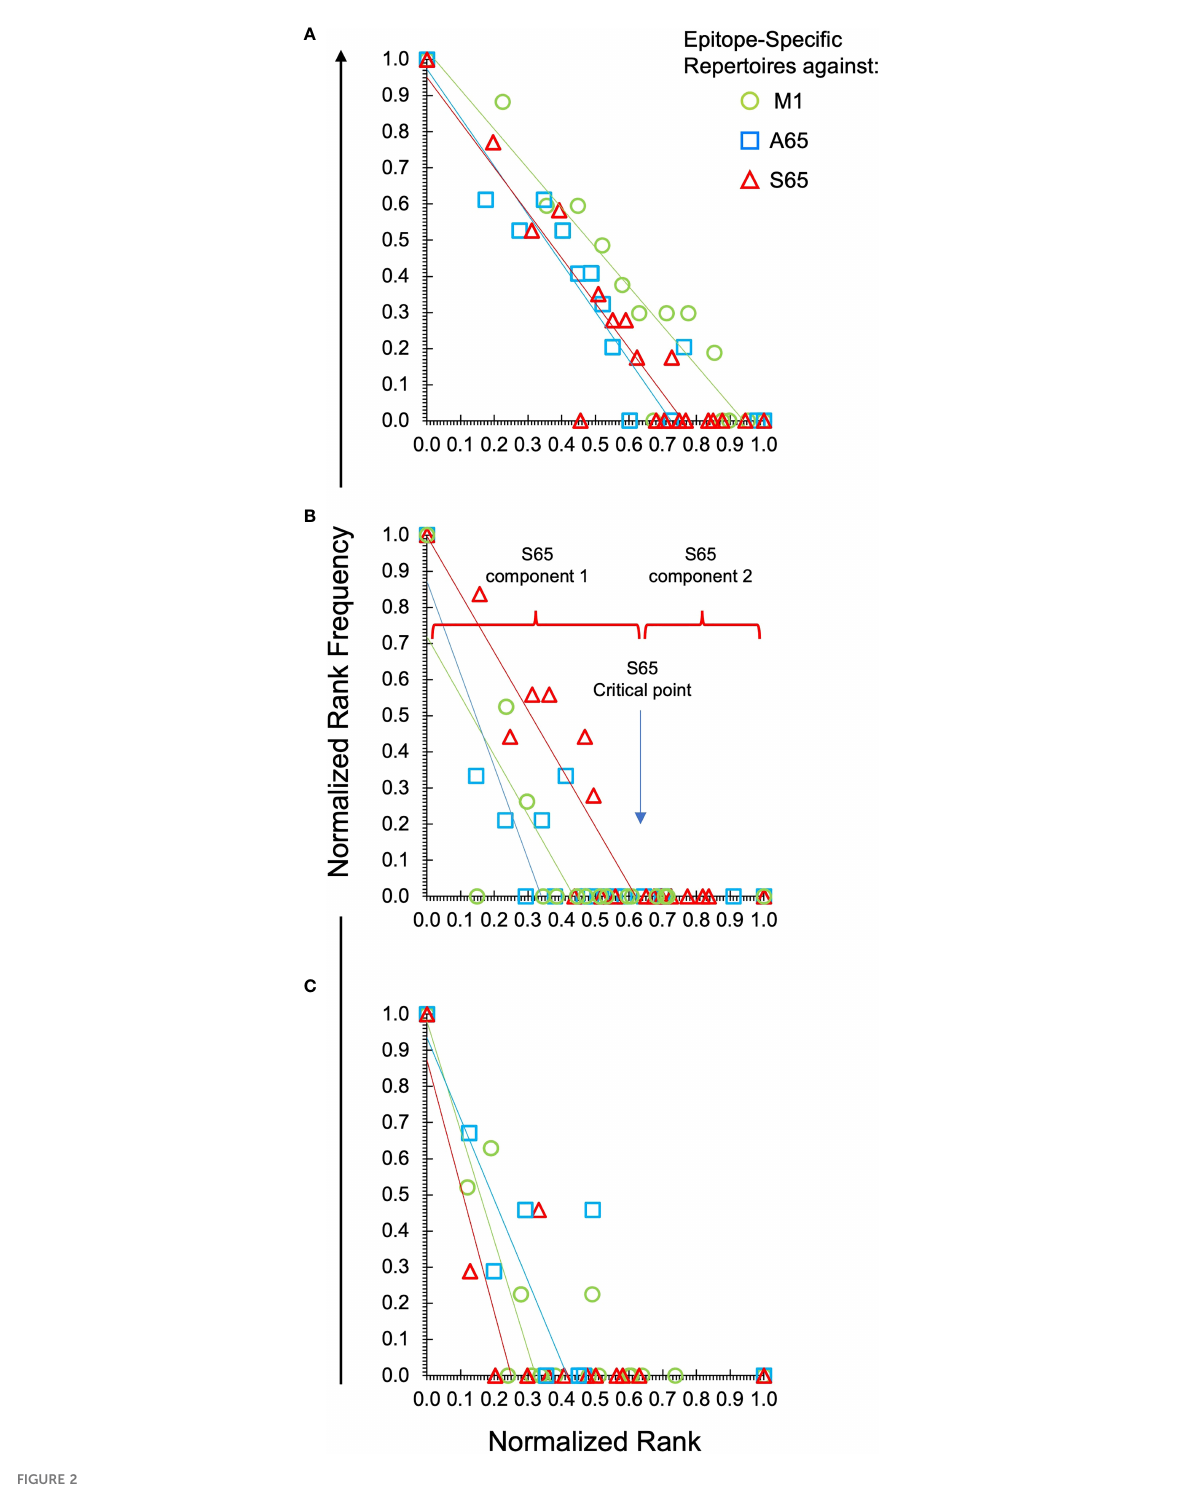
FIGURE 2 Power law-like distribution of clonotypes in each repertoire of each donor and peptide. Natural log-transformed values are fi t to a linear- regression line for the fi rst component of the repertoire. Panel (A) is data from Donor A. Panel (B) for Donor B and Panel (C) for Donor C. Stimulating peptides are identi fi ed by marker color as shown in the legend in panel (A) . The division of the data into the power law-like component 1 and component 2 are shown for the S65 data of Donor B. Details are provided in Supplemental Table